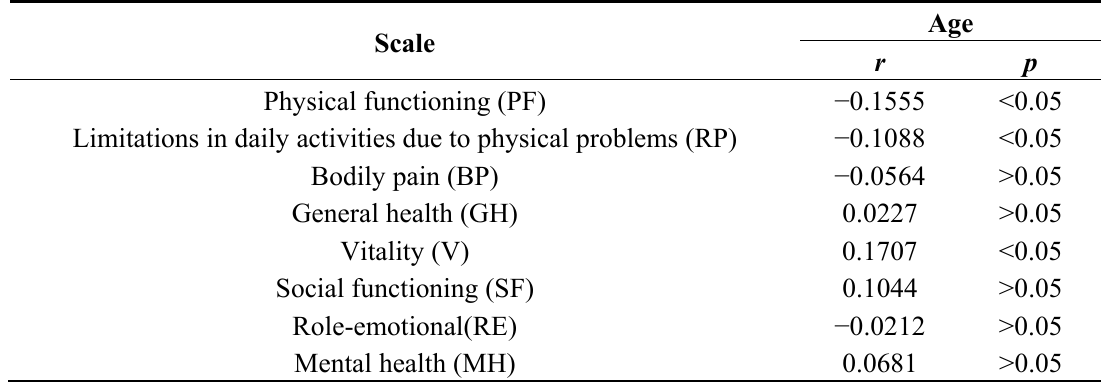
Table 4. Analysis of correlations between quality of life according to SF-36 and age of respondents.